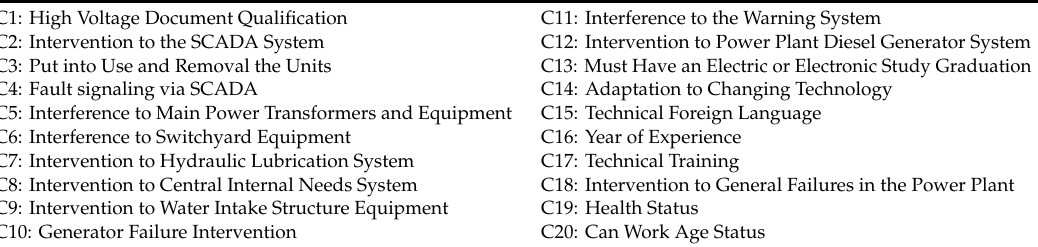
Table 2. Criteria about personnel skills (C1, C2, ... ,